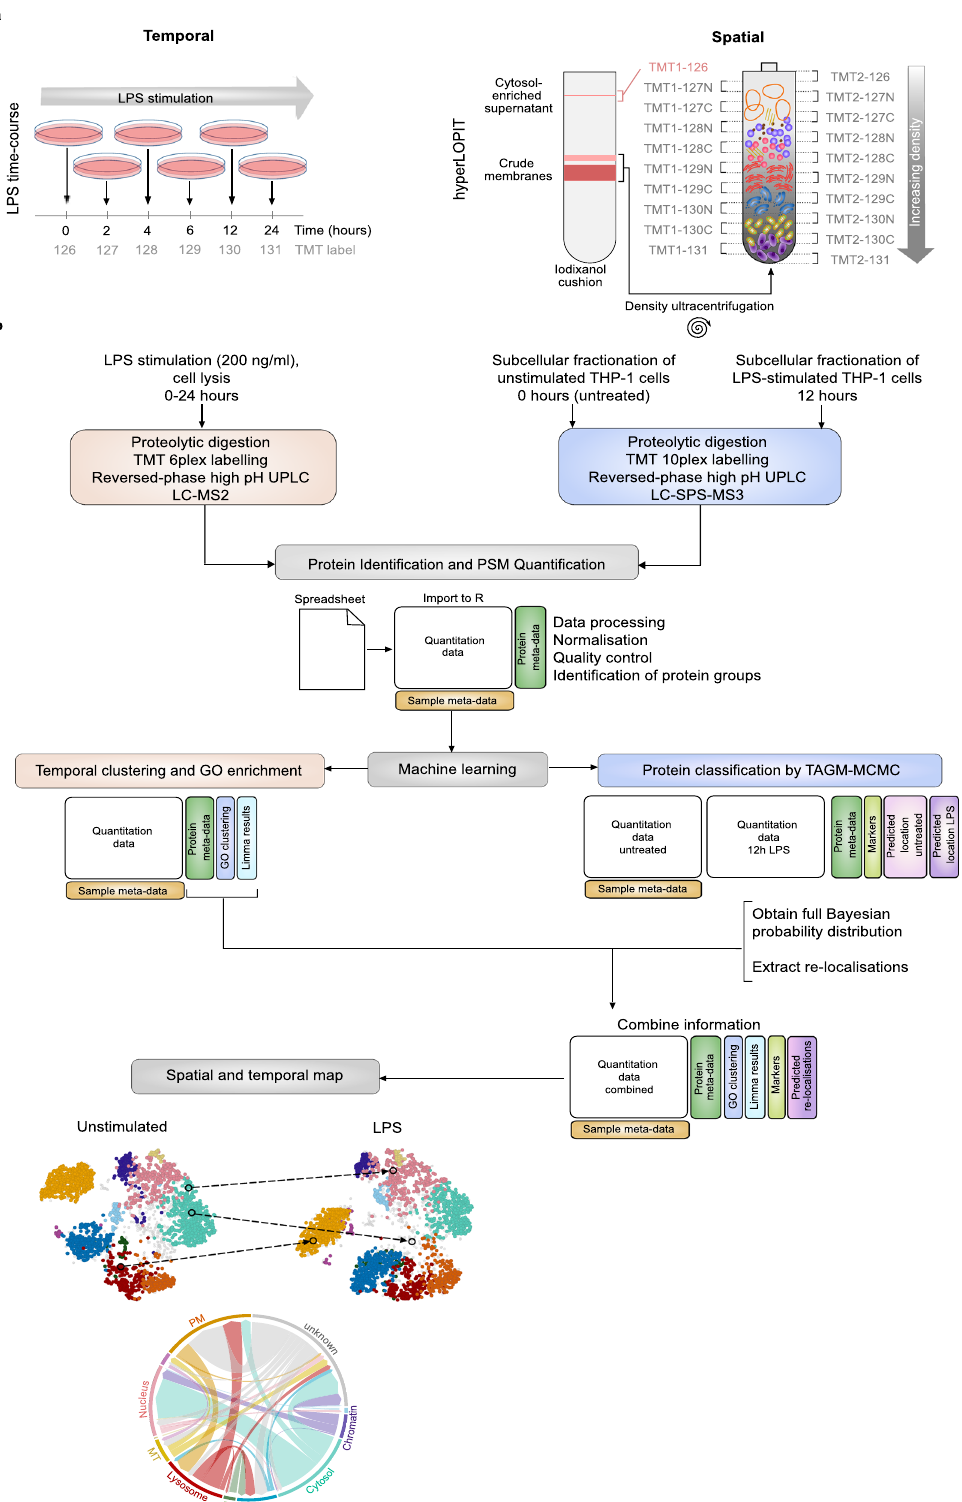
Fig. 1 Overview of the spatiotemporal experimental pipeline. a TMT labelling strategy for the temporal and the spatial MS proteomics analysis. Each experiment was performed in triplicate. b Experimental and computational work fl